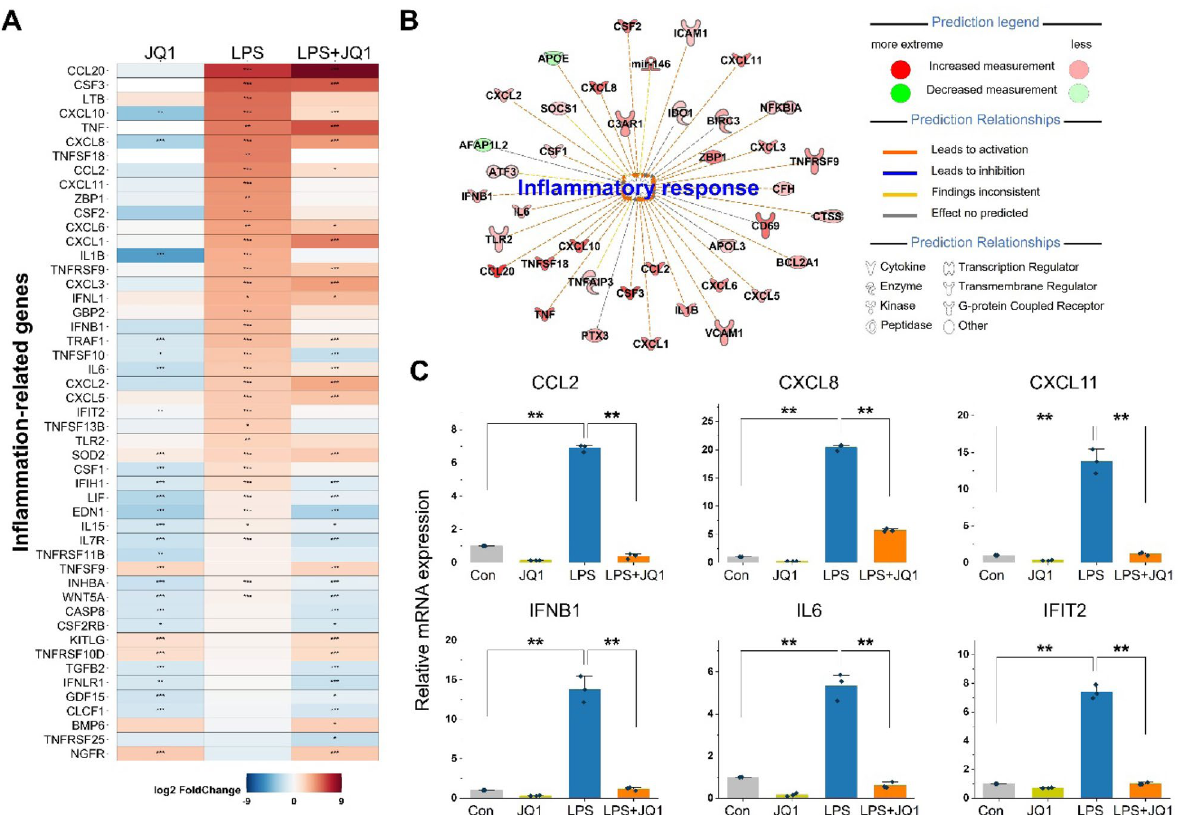
Figure 3. JQ1 inhibits a specific subset of LPS-inducible inflammatory genes. ( A ) Heat map showing chemokine/cytokine and interferon response gene expression in HMC3 cells treated with LPS (100 ng/ml) and JQ1 (500 nM) for 4 h. The color scale shown in the heat map represents the log 2 fold change values. ( B ) IPA downstream effects analysis presenting the mapping of most significant genes related to inflammatory response genes in LPS-treated cells. The DEGs are colored by predicted activation state, such as activated (red) or suppressed (green). The edges connecting the nodes are colored orange (leading to activation of the downstream node), blue (leading to inhibition), and yellow (if the findings underlying the relationship are inconsistent with the state of the downstream node). ( C ) Expression levels of inflammation-related genes were analyzed by qRT-PCR and normalized to GAPDH transcript levels. Overall, LPS-induced inflammatory genes were inhibited by JQ1. The data represent three independent experiments. The values are the mean ± SEM of triplicate experiments (** p <